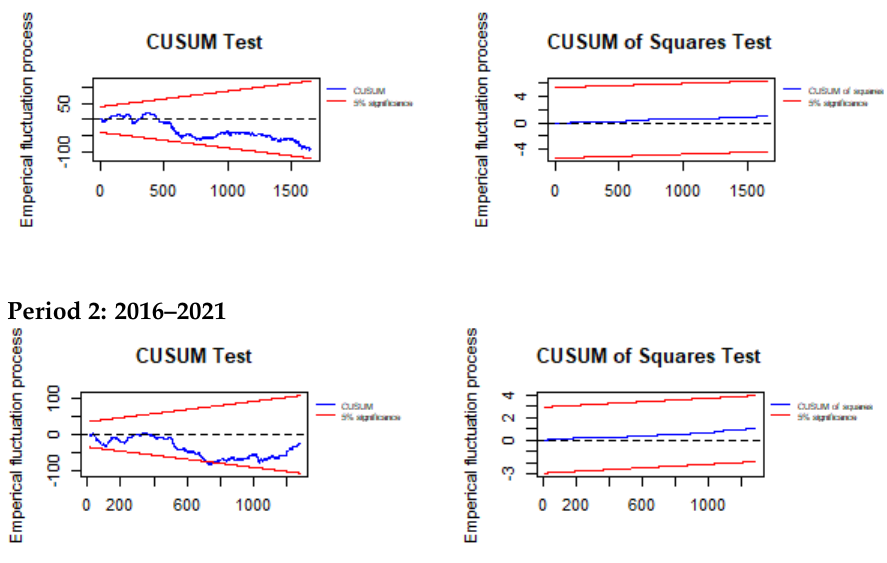
Figure 4. CUSUM and CUSUM of squares